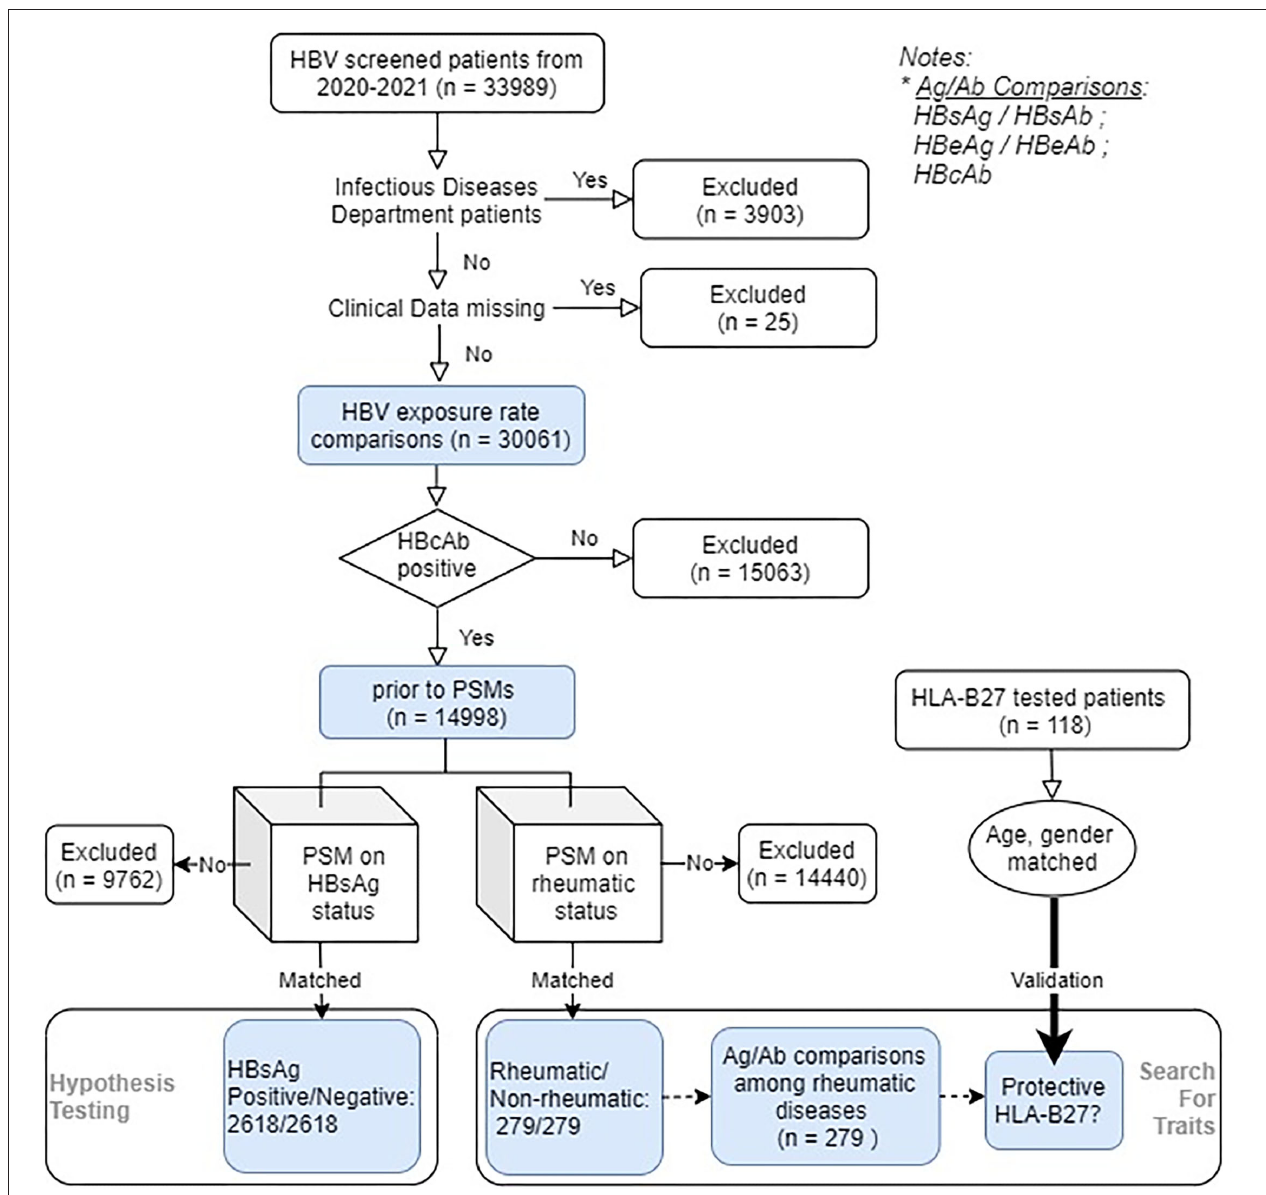
FIGURE 1 | Flowchart of the study. A total of 33,989 eligible hepatitis B Virus (HBV) serologically screened patients entered the study (rheumatic/non-rheumatic patients: 567/33,422), within which 17,906 patients were HBV core antigen (HBcAb) positive. Initially included patients were used to estimate the HBV exposure rates. Among HBcAb-positive patients (HBV-exposed patients), two parallel rounds of PSM were conducted. The first one aimed to check the impact of rheumatism on the infection outcome, whereas the second one focused on evaluating the HBV-specific humoral immunity [viral antigen (Ag)/antibody (Ab)] differences. Viral Ab levels were further compared among different rheumatic diseases. The role of human leukocyte antigen (HLA) class I molecule B27 (HLA-B27) on HBV infection outcome was further validated using another set of age, gender-matched